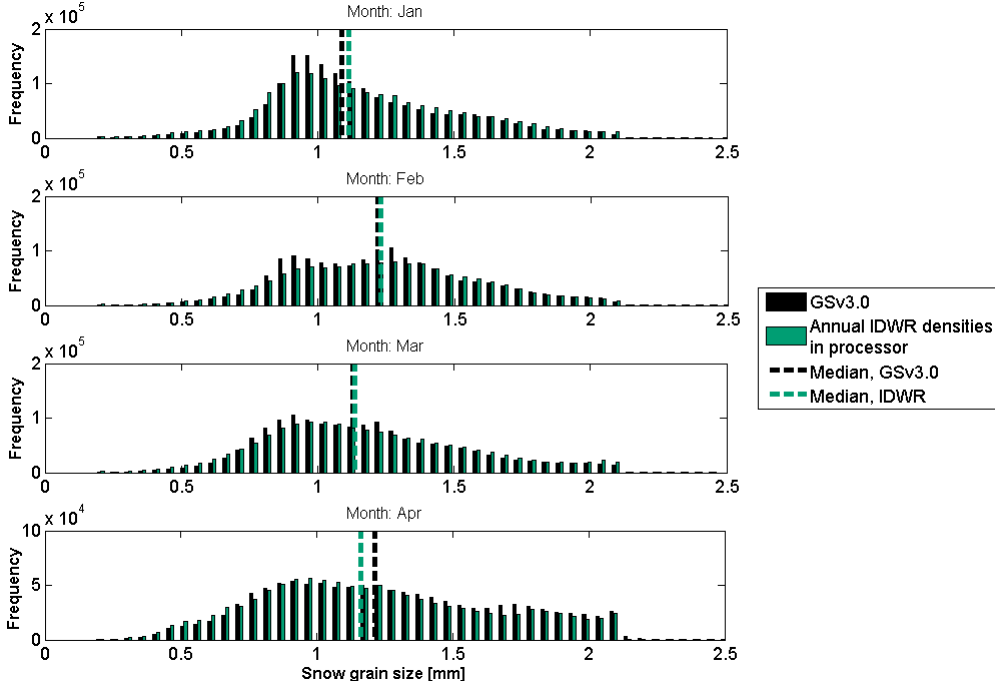
Figure 6. Histograms of effective snow grain size values for January, February, March, and April 2005. The monthly median value is shown with dotted lines.